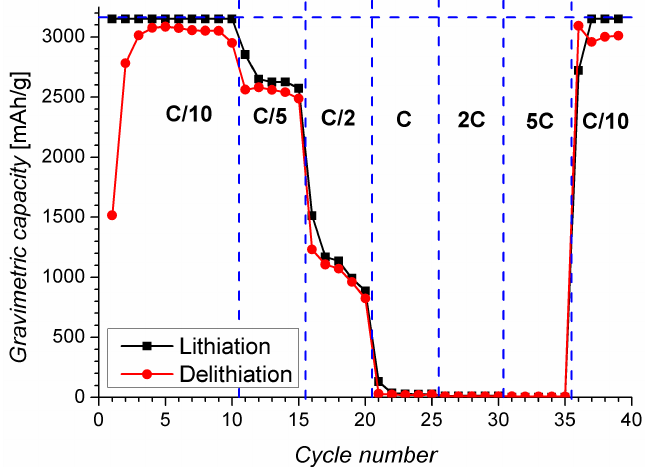
Figure 2. Curve of capacity vs. cycle number of the microwire anode, under galvanostatic mode at different C rates.